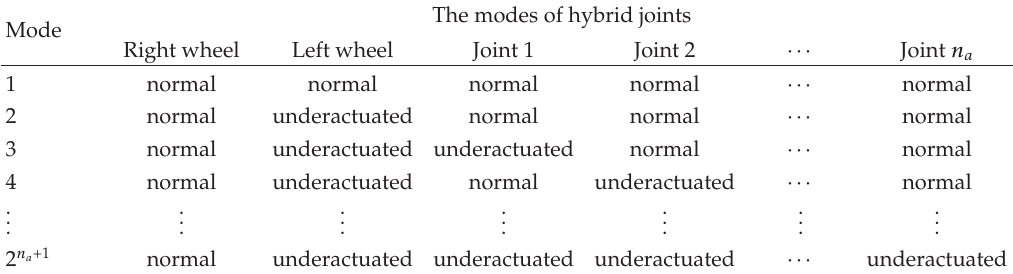
Table 1: The modes of